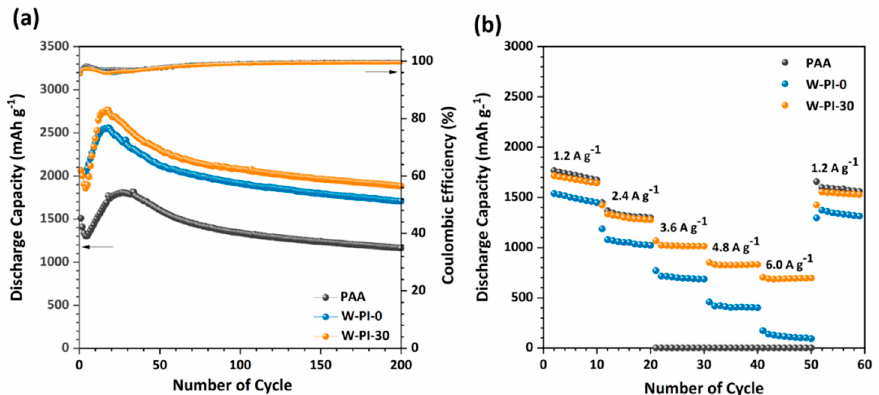
Figure 4. ( a ) Cycling performance and ( b ) rate capabilities of Si electrodes with PAA, W − PI − 0, and W − PI − 30 binder systems. Experimental conditions: ( a ) 200 cycles, current density: 1200 mA g − 1 , potential range: 0.05 − 2.0 V at 25 °C.